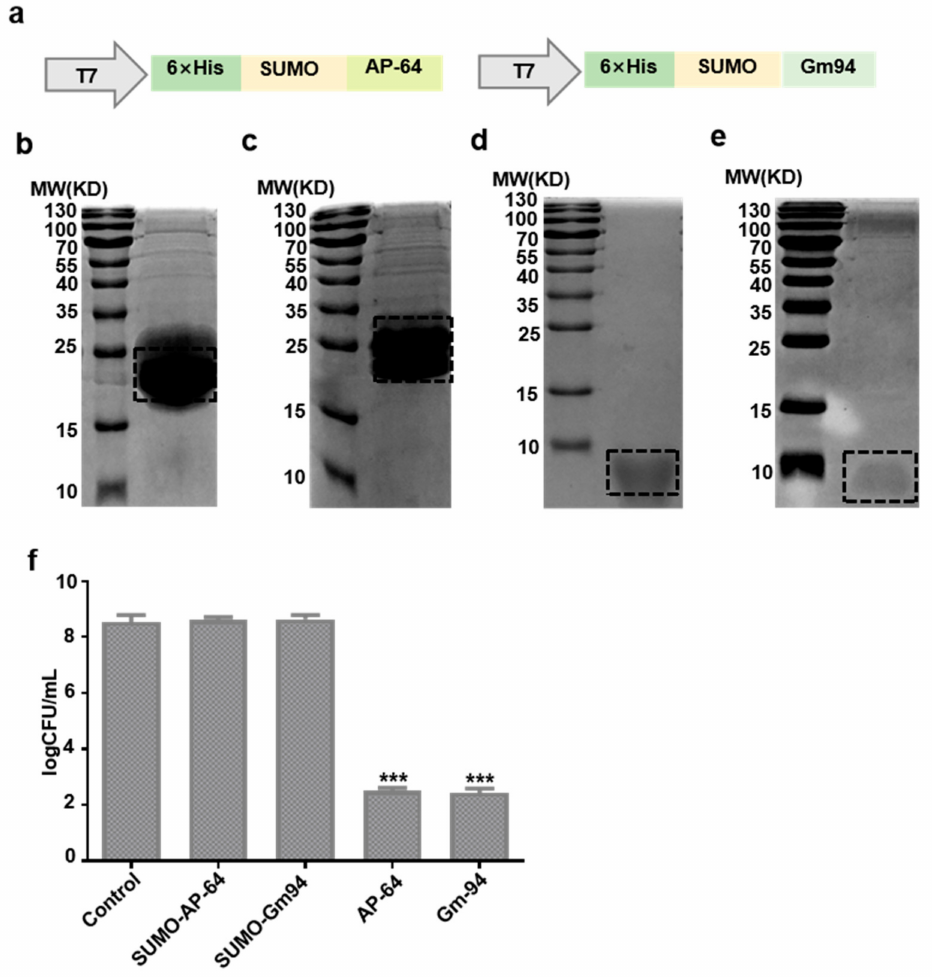
Figure 2. Expression and purification of purification proteins. ( a ) Schematic drawing of the constructs used for recombinant protein expression. ( b – e ) SDS–PAGE analysis of SUMO-AP-64, SUMO-Gm94, AP-64, and Gm94, corresponding to the expected molecular weight of 21 KD, 21.4 KD, 7.2 KD, and 7.6 KD, respectively. The protein positions are highlighted by the dotted line. ( f ) Effects of the proteins on the growth of E. coli DH5 α . Bacteria were treated with the indicated agents at a concentration of 1 µ M. Data are mean ± SD of three independent experiments with each experiment conducted in triplicate. *** p < 0.001, significantly different from the